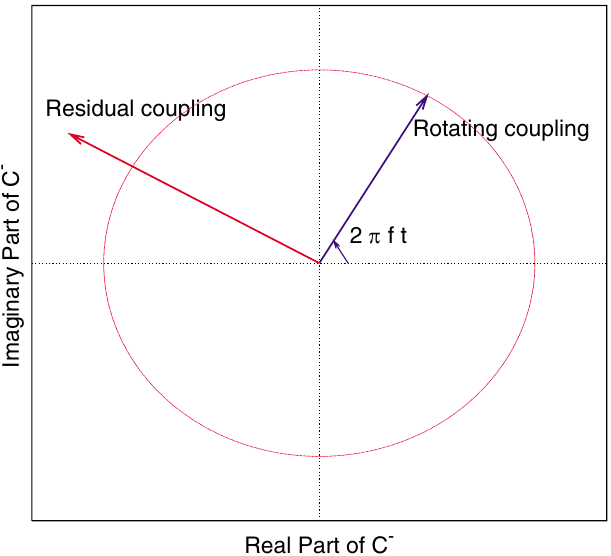
FIG. 1. (Color) Schematic plot of coupling angle